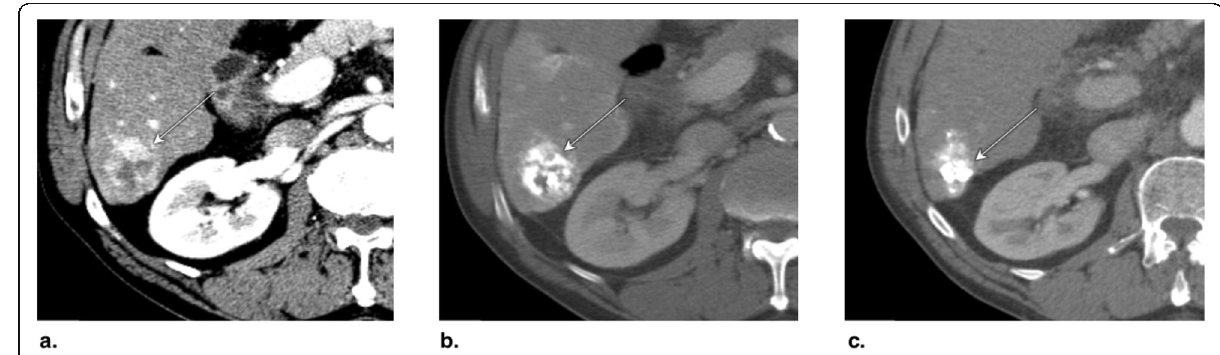
Fig. 22 Axial CT obtained ( a ) pretreatment: image in late arterial phase (AP) shows nonrim arterial phase hyperenhancement of a 3.5-cm LR-5 observation in segment VI (arrow). b 1 month post transarterial chemoembolization (TACE): image in portal venous phase shows ethiodized oil retention with optimal targeting (arrow). c 2 months post TACE: image in late AP shows decrease of ethiodized oil retention (arrow). Density